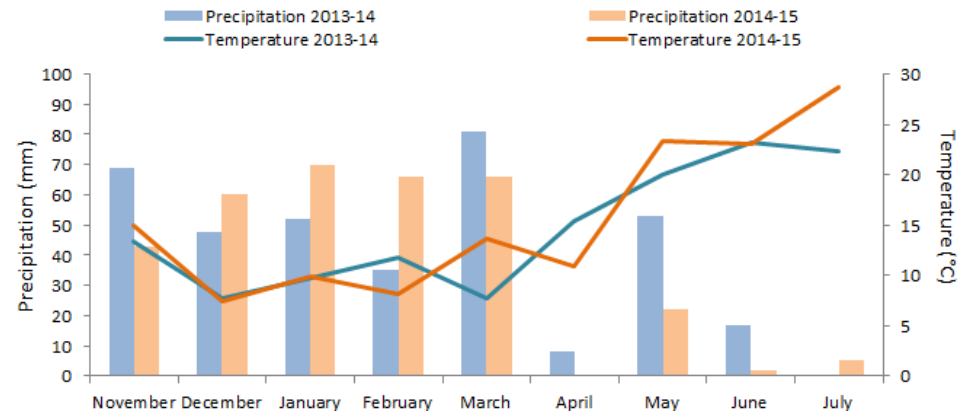
Figure 7. Monthly precipitation and temperature recorded in Nebeur/Kef site during 2013/14 and 2014/15 cropping seasons.